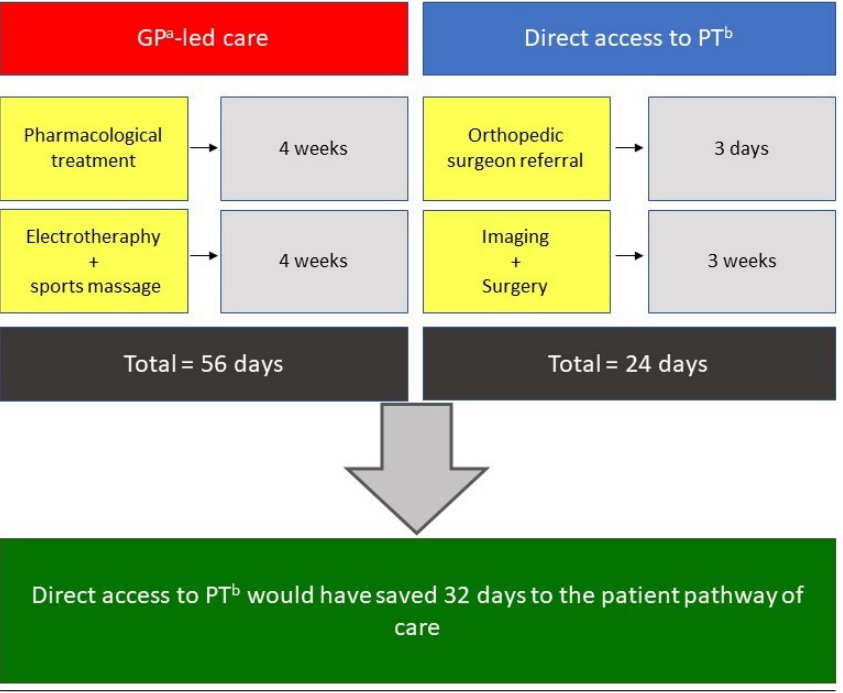
Figure 5. Direct Access to a PT versus GP-led care: a : general practitioner; b : physical therapist ; .